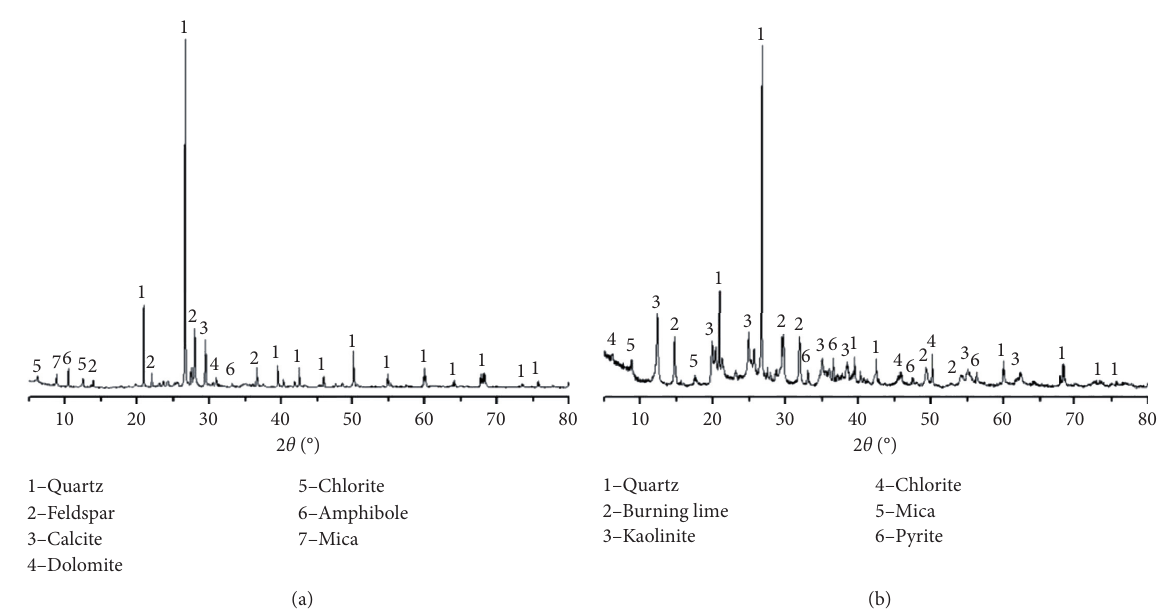
Figure 4: XRD mineralogical composition analysis results of aggregate: (a) YRS and (b)